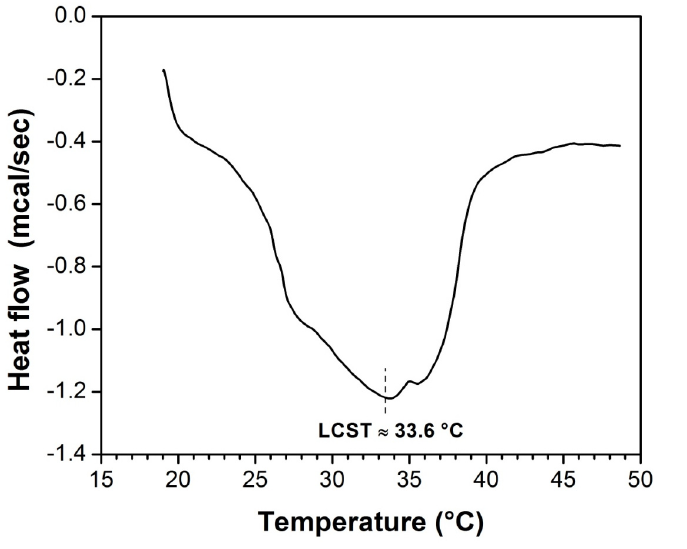
Figure 8. DSC thermograms of swelled SR-g-(NVCL-co-NVIM) with distilled water at a heating rate of 1 °C min − 1 from 20 to 50 °C. LCST is